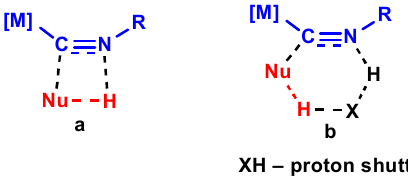
Figure 1. Types of transition state of the concerted nucleophilic addition to metal-bound isocyanides.